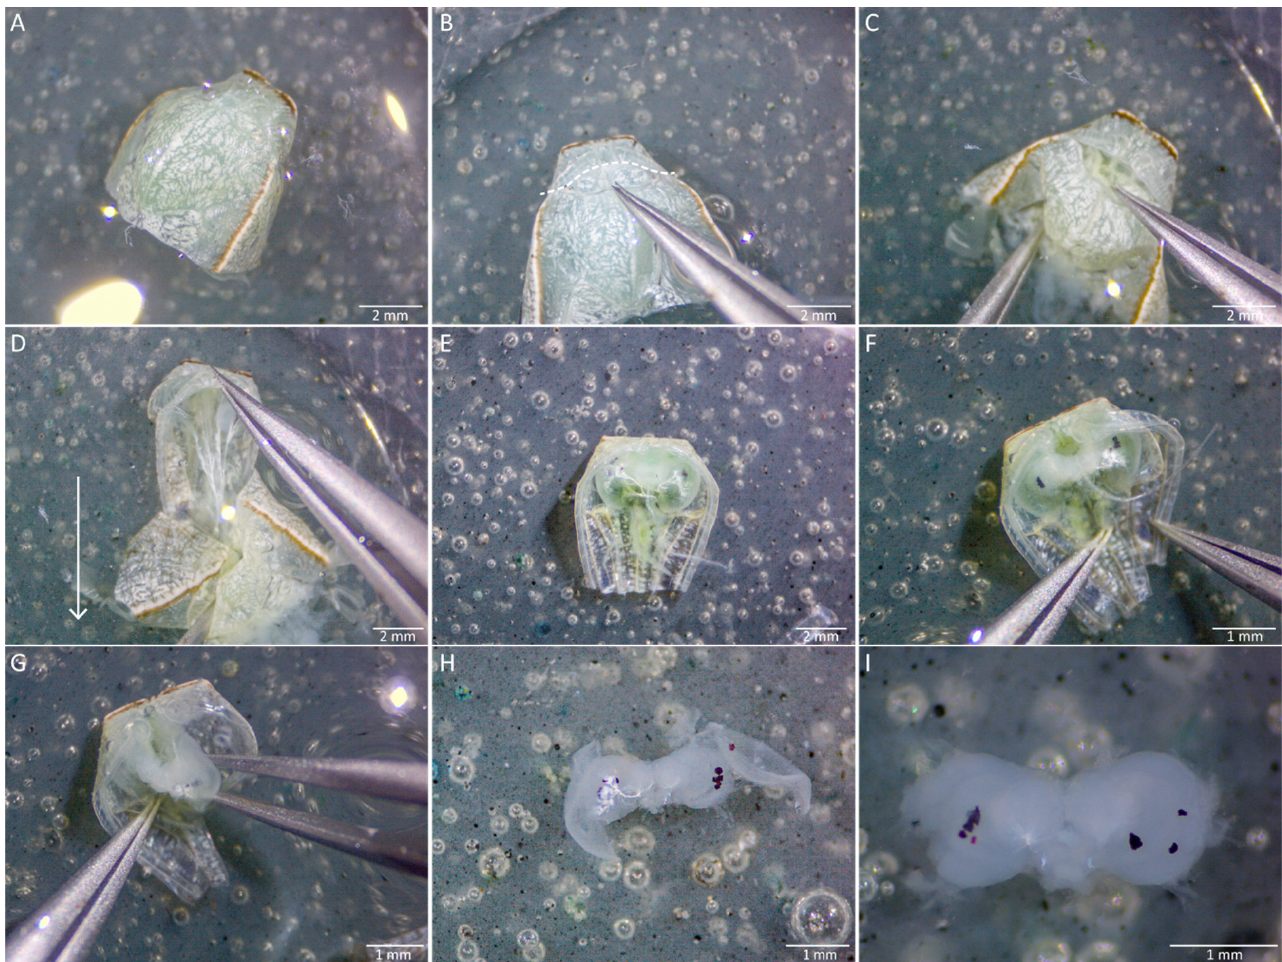
Figure 5. Dissection of a pupal brain at 30% pupal development. ( A ) The anterior part of the pupa is submerged into 1× PBS. ( B ) The thorax cuticle is pushed down and ( C ) detached at the suture at the base of the head (along the dashed line) to make a small opening. ( D ) The thoracic tissue and cuticle are pulled away horizontally from the head tissue (following the direction of the arrow). ( E ) The developing head is visible at the bottom of the pupal cuticle. ( F ) Extra pieces of pupal cuticle are removed. ( G ) Then, the brain is gently scraped out. ( H ) While detached from the pupa cuticle, extra head tissue can be removed from the brain (e.g., cornea, antennae, trachea (seen in a bright white colour)). ( I ) The clean brain can be used for downstream analyses.